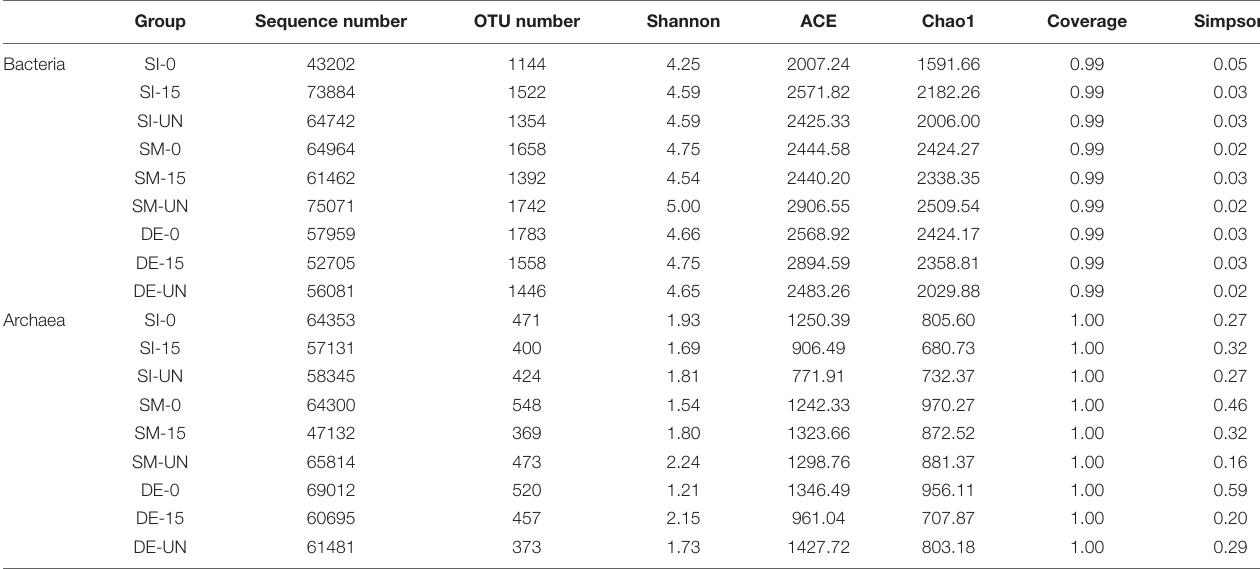
TABLE 5 | Ecological indexes of bacteria and archaea in selected groups after